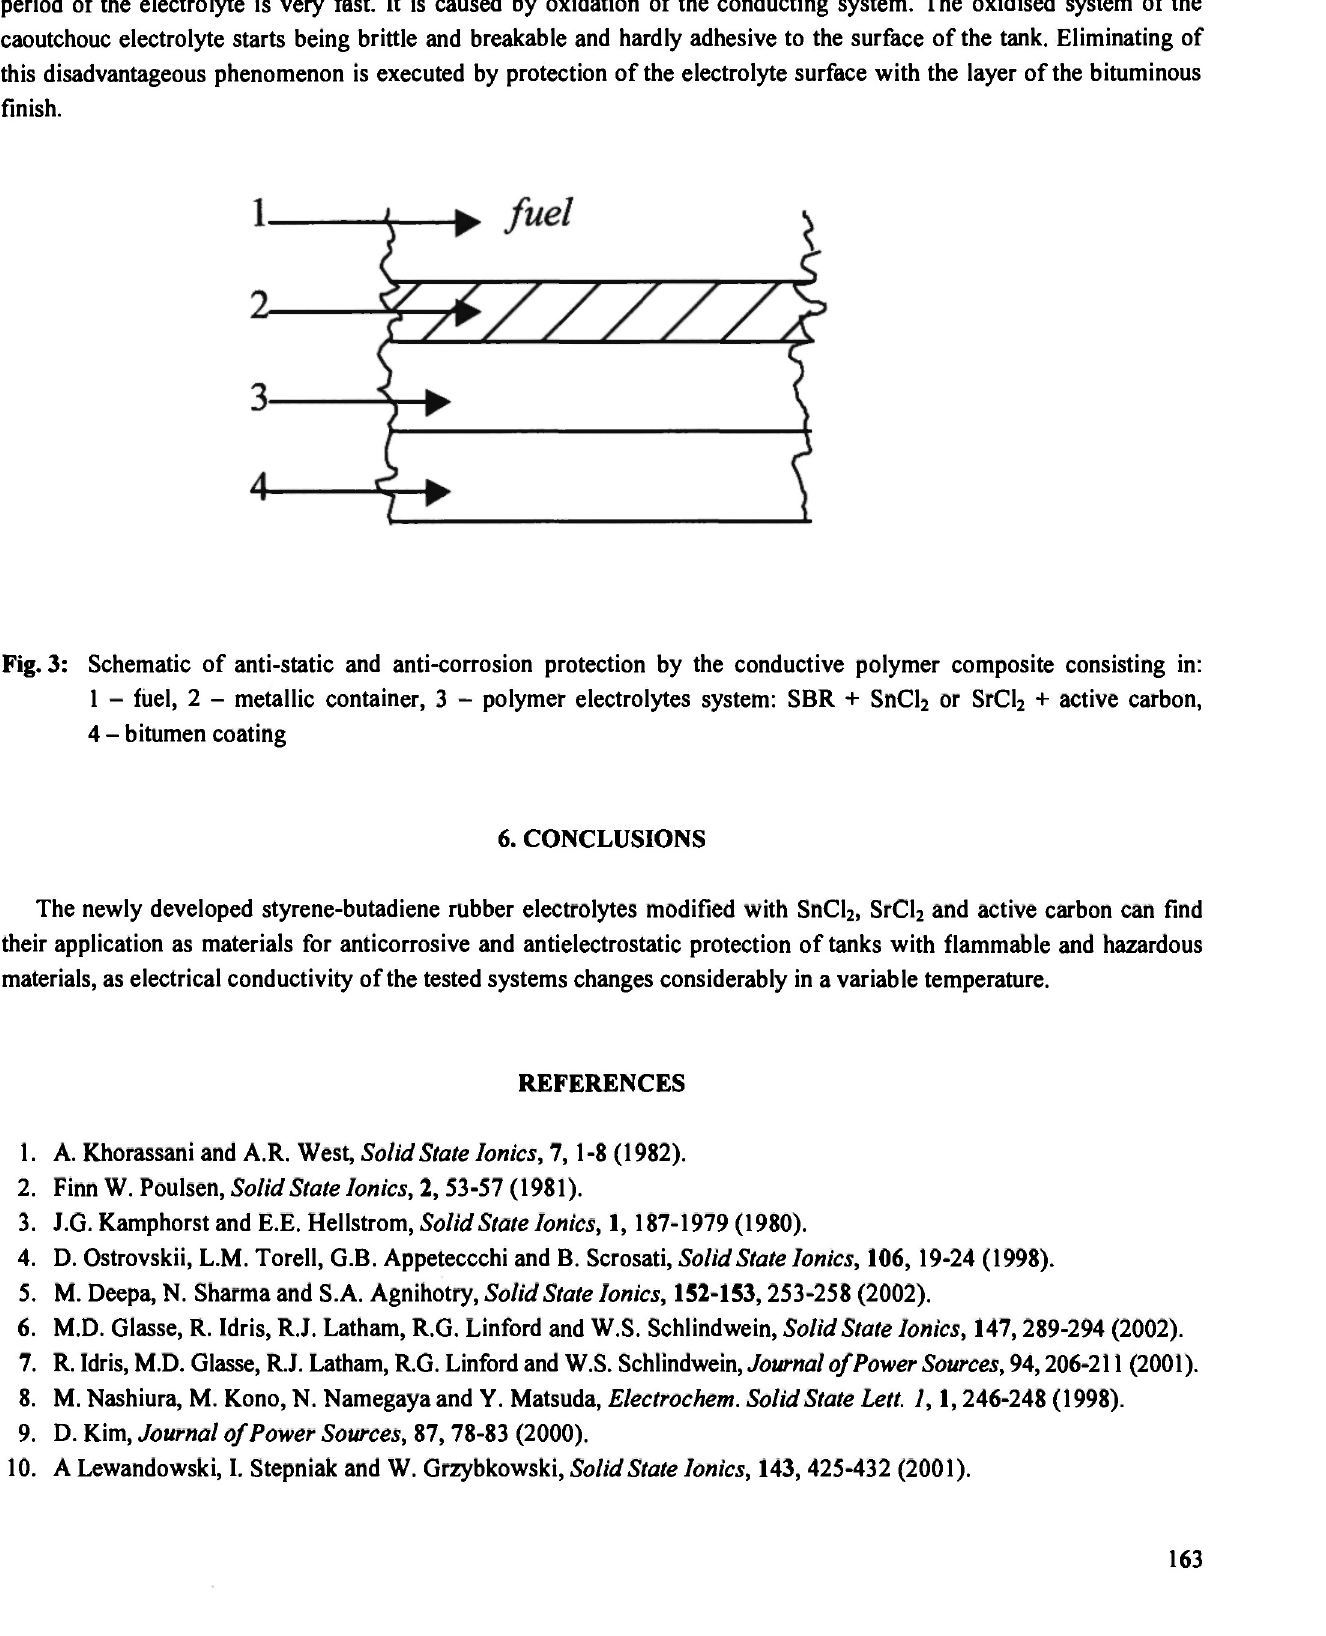
Fig. 3: Schematic of anti-static and anti-corrosion protection by the conductive polymer composite consisting in: 1 - fuel, 2 - metallic container, 3 - polymer electrolytes system: SBR + SnCl 2 or SrCl 2 + active carbon, 4 - bitumen